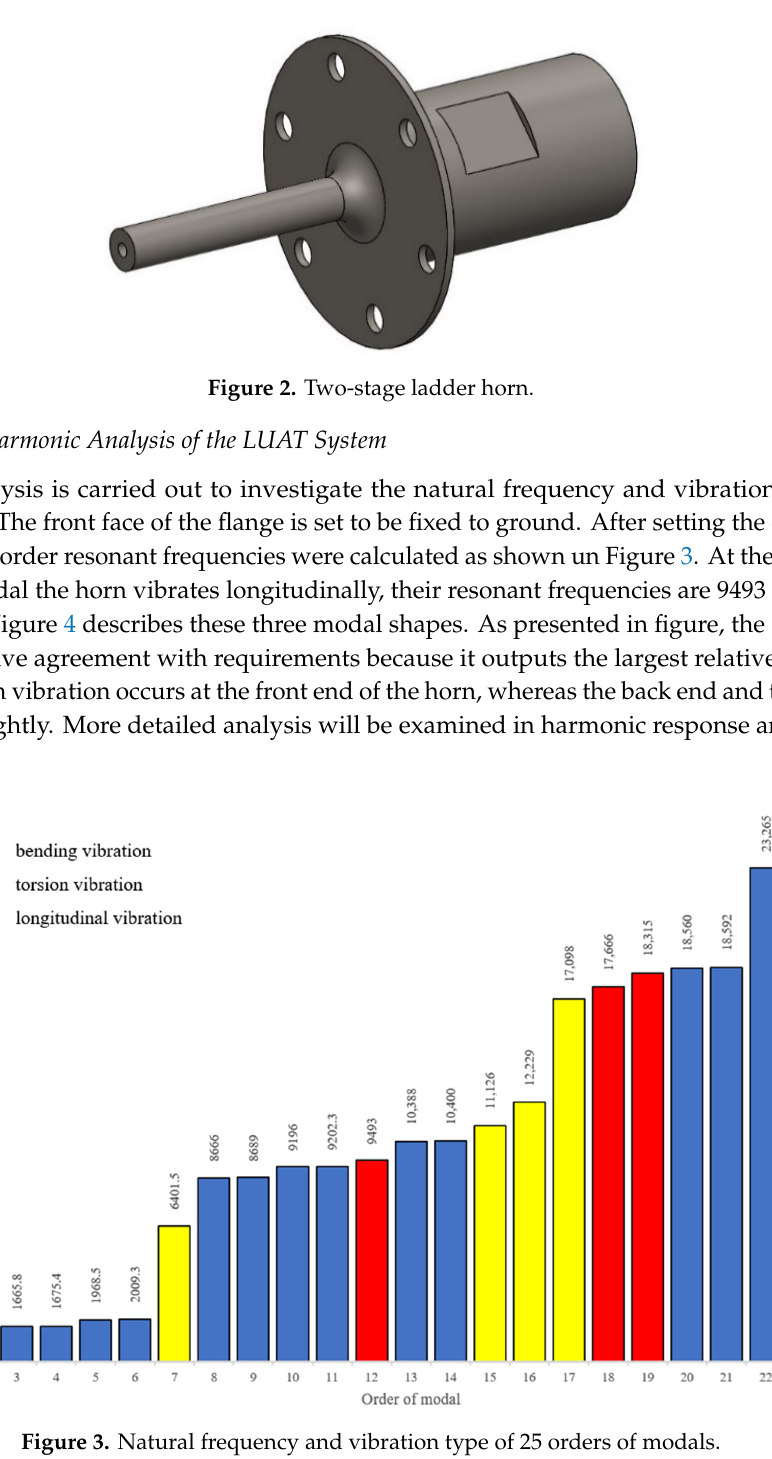
Figure 4. Modal shape of the first three longitudinal vibrations. ( a ) 9493 Hz; ( b ) 17,666 Hz; ( c ) 18,315 Hz. In the modal analysis, the vibration mode is relative value, which cannot reflect the true amplitude of the ultrasonic turning device at the tool. It is crucial to further analyze the harmonic response of the device on the basis of the 19th mode to obtain the amplitude at the tool tip. The harmonic response analysis is then conducted by workbench. Remote force is applied along the horn direction on its back end. The sweep range is set to between 17,000 Hz and 19,000 Hz (based on the 19th mode) with 100 solution intervals. Figure 5 shows the output displacement curve of the setting frequencies regarding the turning tool installed on the top of the horn. It could be observed that near